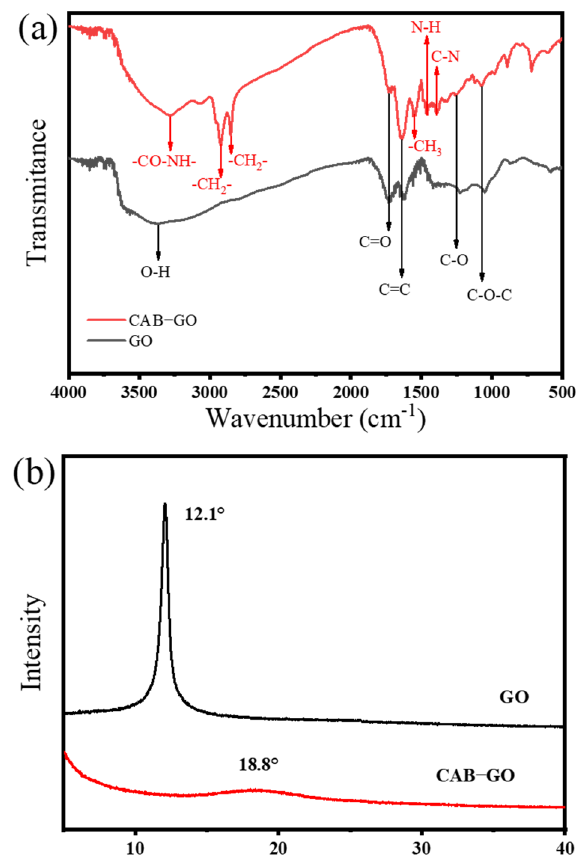
Figure 4. FTIR spectra ( a ) and XRD patterns ( b ) of GO and CAB − GO samples.